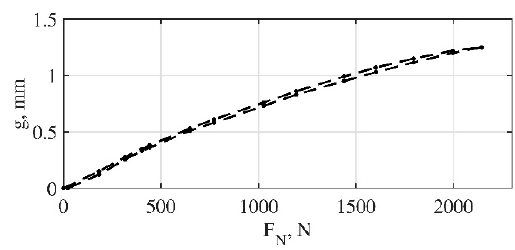
Figure 15. Deflection characteristics as a function of load .